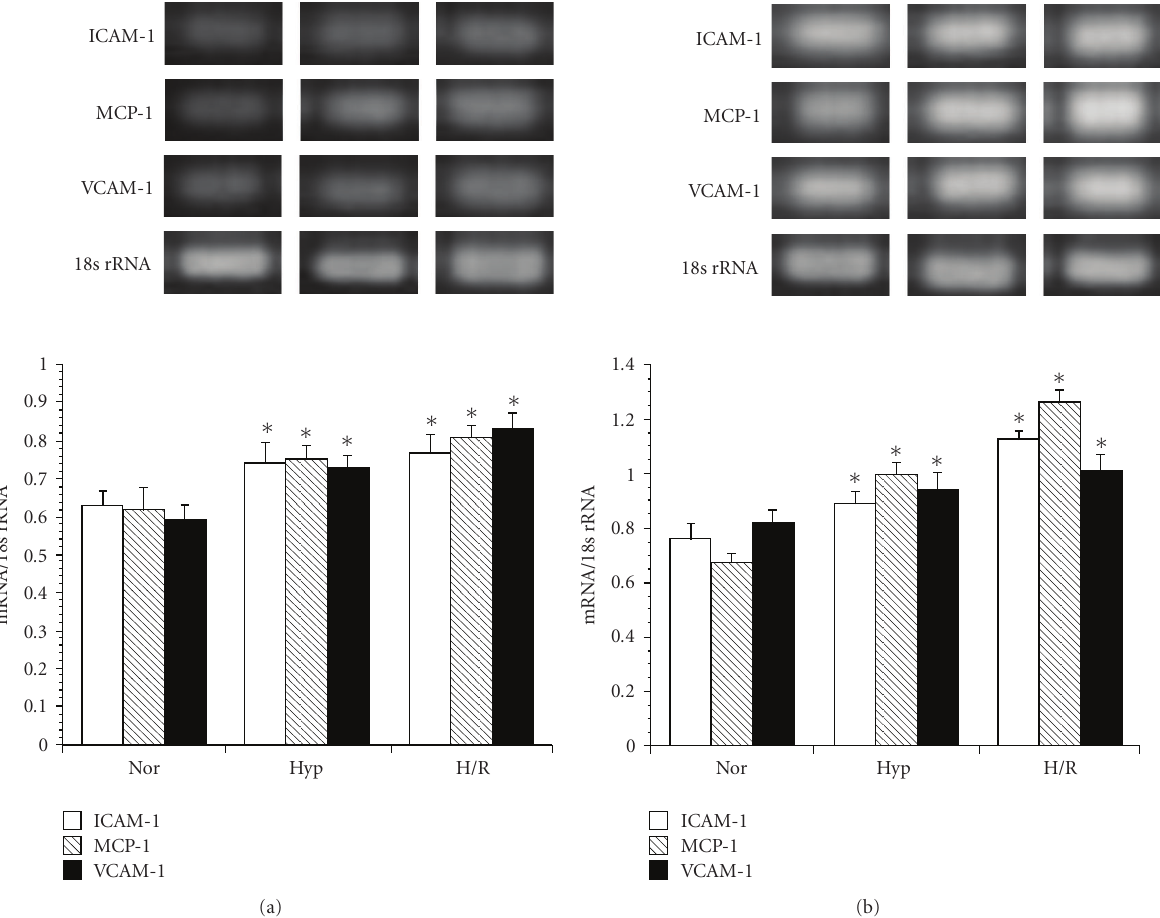
Figure 5: A comparison between the gene expression levels of ICAM-1, MCP-1, and VCAM-1 in astrocytes isolated from WKY/IZM and SHRSP/IZM during hypoxia and reoxygenation. The astrocytes isolated from WKY/IZM (a) or SHRSP/IZM (b) were incubated under hypoxia (1% O2, 24 hour) or hypoxia + reoxygenation (21% O2, 3 hour) as previously described [13, 15]. The ICAM-1, MCP-1, and VCAM-1 mRNA measurements were carried out as described in Figure 1 and in the text. The bars represent the mean ± SD ( n = 4). Asterisk ( ∗ ): P < . 05 compared with the normal condition values. Nor: normal condition, Hyp: Hypoxia, H/R: hypoxia and